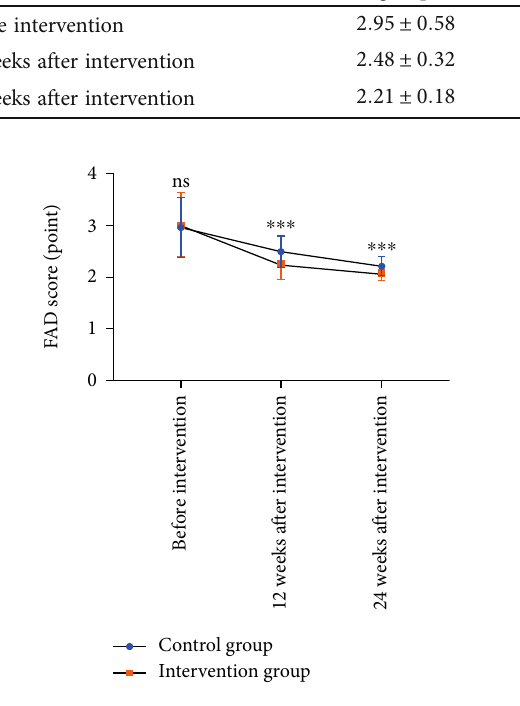
Figure 4: Comparison of FAD score (total function) between the control and intervention group. n = 74 ; ∗∗∗ p < 0 : 001 . ns: not signi fi